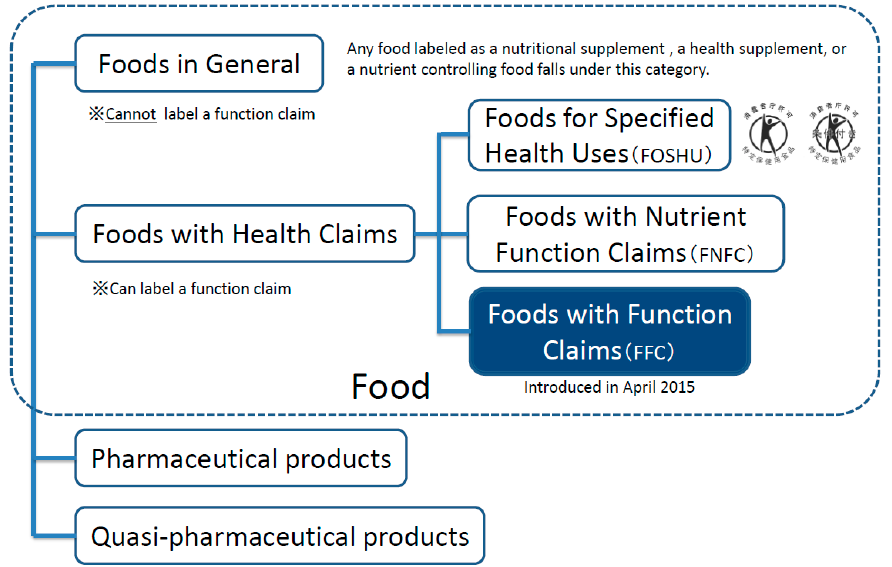
Figure 1. Food labeled with certain nutritional or health functions in